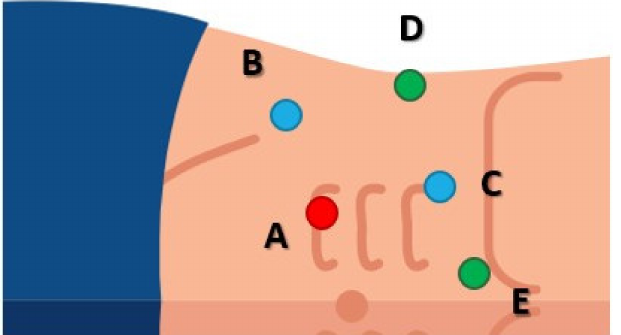
Figure 2. Trocar placement. ( A ) 10 mm optic trocar, placed paraumbilically, at the right border of the rectus abdominis muscle. Two 10 to 12 mm working trocars were inserted for the main surgeon. ( B ) Working trocar for the left hand, placed on the imaginary line drawn between the umbilicus and the anterior iliac spine, 2 cm cranially from the latter. ( C ) Working trocar for the right hand, placed on the line that links the umbilicus with the costal margin, 2 cm below the latter. Next, two trocars of 5 mm each were placed for the assistant surgeon. ( D ) Trocar placed on the mid-axillary line, used